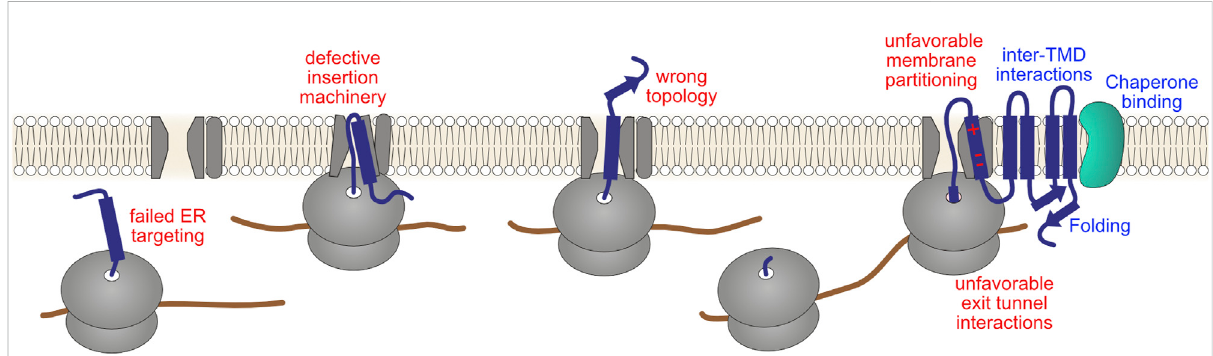
FIGURE 6 Challenges in complex transmembrane protein biogenesis. Incorporation of proteins into the membrane entails overcoming important biophysical challenges: hydrophobic protein segments must be shielded from the crowded aqueous cytosol as well as transported past the highly polar surface of the membrane into the hydrophobic core of the lipid bilayer. Therefore, the majority of transmembrane proteins are assembled co- translationally atthe ER. This entails targeting of ribosomes to theSec61 translocon, de fi ning the proteintopology (orientation in relation to the membrane plane), inserting TMDs into the membrane via concerted action of the translocon and additional folding/insertase complexes, translocation ofsolubleluminaldomains,initial stagesoffolding,andinsomecasesglycosylationofthenascentchain.Potential failuresintheseco- translational processes (red labels), either due to defective cellular machinery or a defective nascent chain, might in principle affect ribosomal elongation. Productive maturation steps, such as folding of soluble domains, formation of correct inter-TMD interactions and inter-domain assembly, and chaperone-mediated remodeling (blue labels), might aid ribosomes in overcoming these